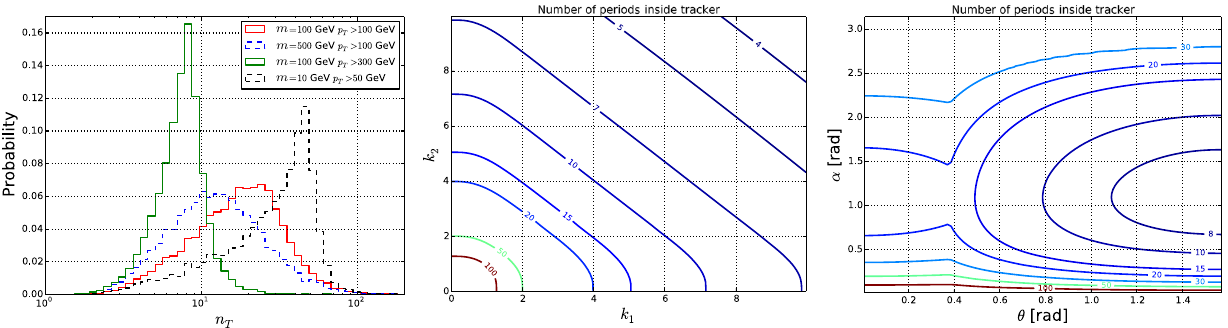
Fig. 2 Left: distributions of number of periods for different quirk masses and quirk-pair transverse momenta (from numerical simula- tion). Middle and right: the projected (parameters are set at benchmark